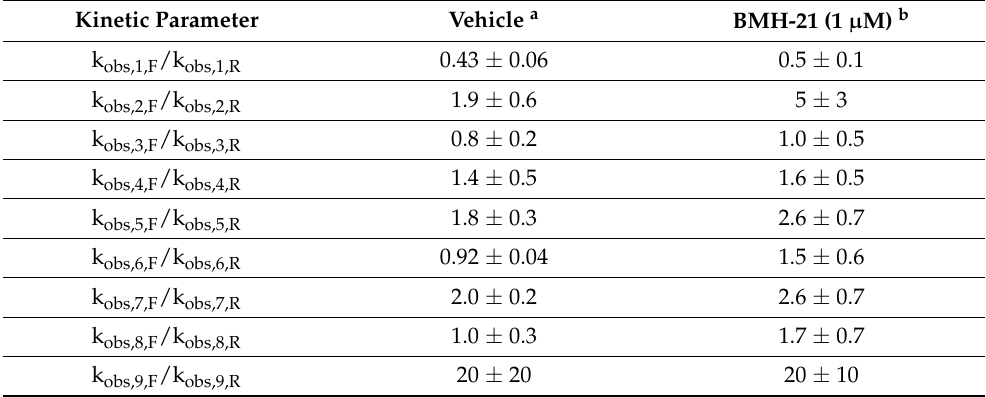
Table 2. Ratios of forward and reverse parameter values from Pol II vehicle- and BMH-21-treated multi-nucleotide time courses.